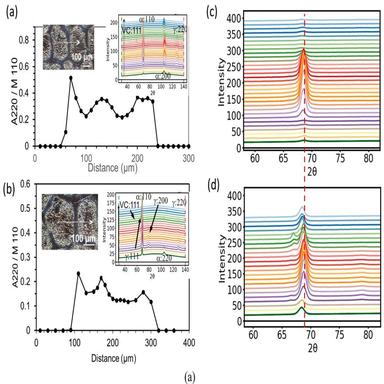
µ-XRD analysis on the 85% (a, c) and 105% (b, d) binder saturation samples. (a) and (b) represent the line across which XRD patterns were acquired (Refer to the inset), and the ratio of intensity austenite (220) and martensite (110) peaks across the line. (c) and (d) represent the shift in 2θ position of (110) martensite peak for the 85% and 105% binder saturation sample respectively.